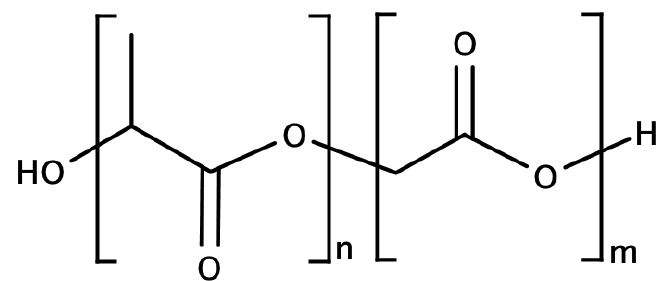
Figure 8. Chemical structure of polylactic-co-glycolic acid (Adapted with permission from [31], available online)